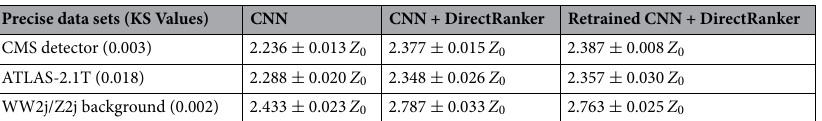
Precise data sets (KS